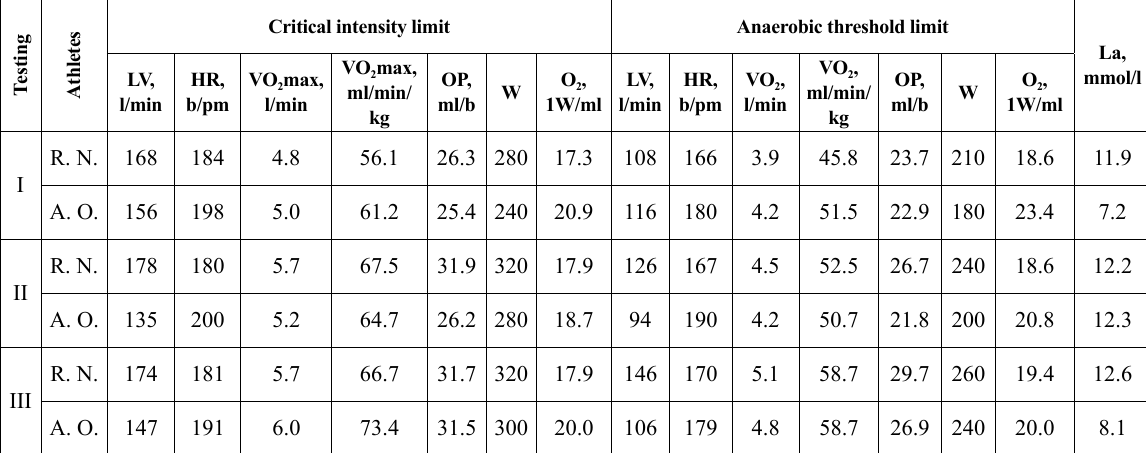
Table 2. change in kayak rowers’ aerobic capacity indices at critical intensity and anaerobic threshold limits during preparatory and competitive mezzo-cycles